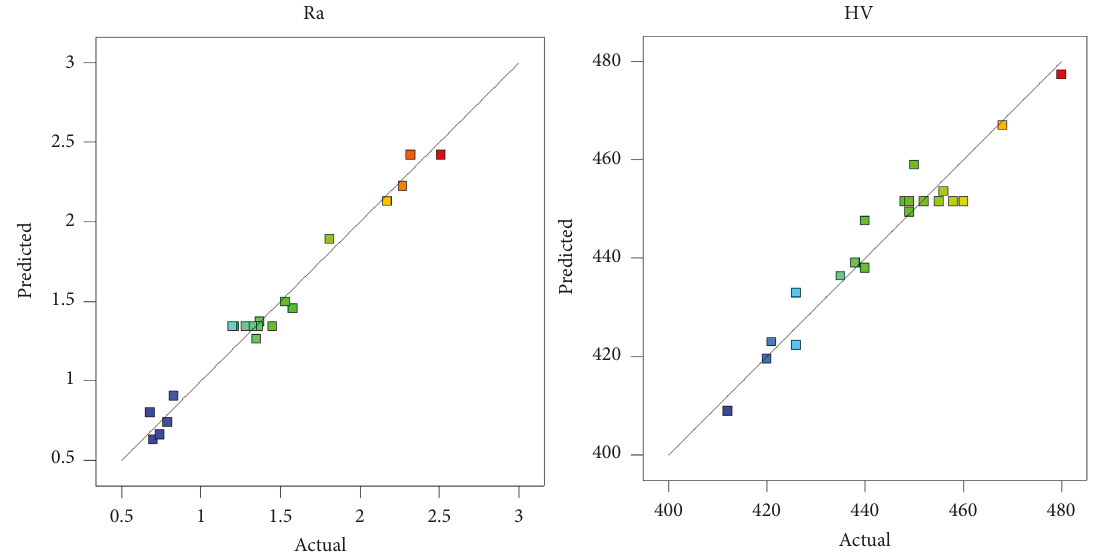
Figure 2: Comparison of prediction models for Ra and HV